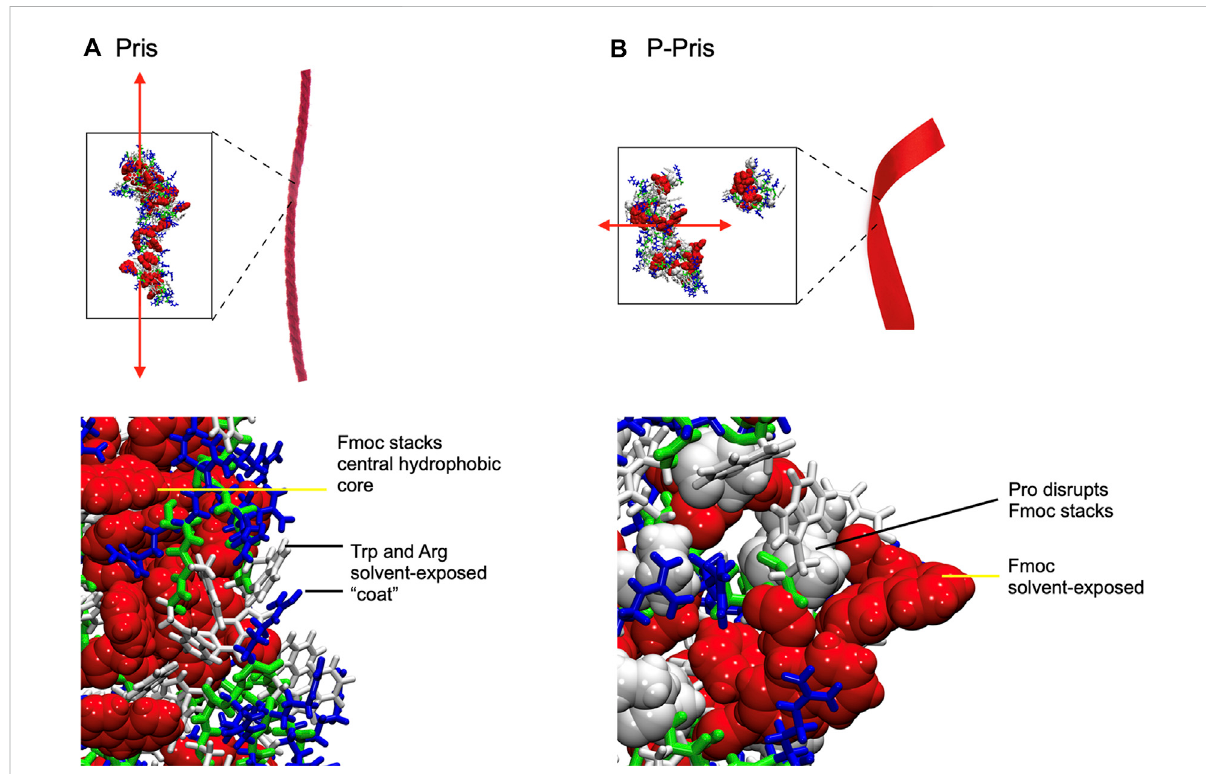
FIGURE 4 Final Molecular Dynamics simulation snapshots of Priscilicidin (A) and P-Priscilicidin (B) , with conceptual cartoon representations of extended fi brils(redribbons)drawnforillustrationonly.FmocgroupsformpartiallyorderedringstacksinPriscilicidin,sequesteredfromsolventbyTrpandArg (A) , which in contrast are disordered and solvent-exposed in P-Priscilicidin (B)